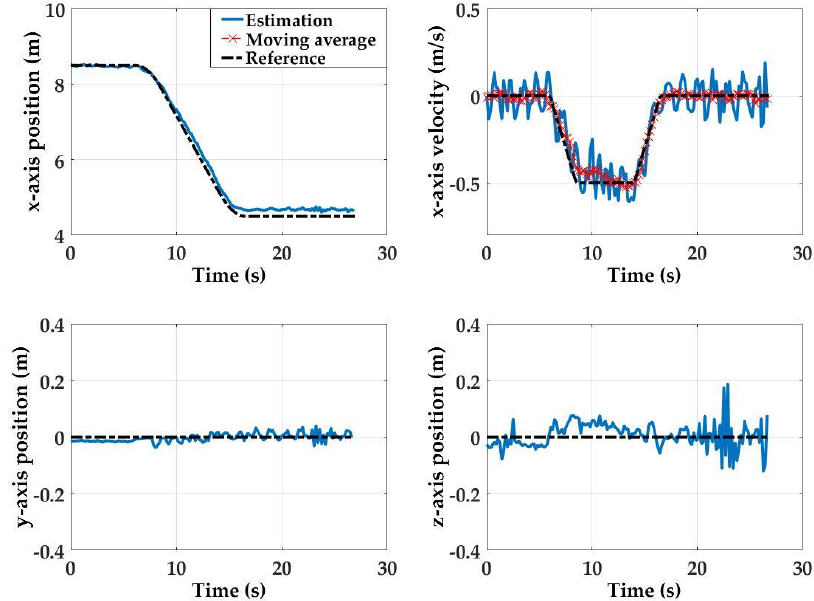
Figure 10. Empirical results for position estimations for Test 1: ( a ) reference and x -axis position estimate; ( b ) velocity reference and raw and smoothed velocity estimates; ( c ) raw and smoothed y -axis position estimates; and ( d ) raw and smoothed z -axis position estimates.